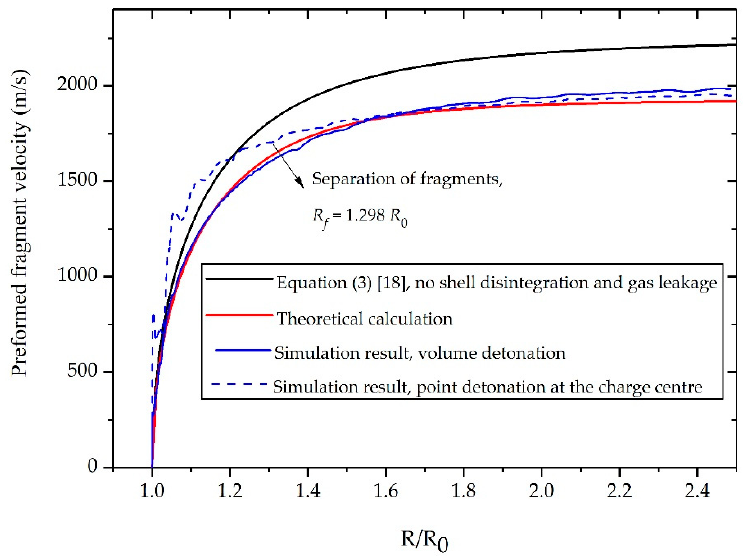
Figure 6. Velocity histories of fragments generated from a preformed-fragment fabricated from AISI 1018 steel.